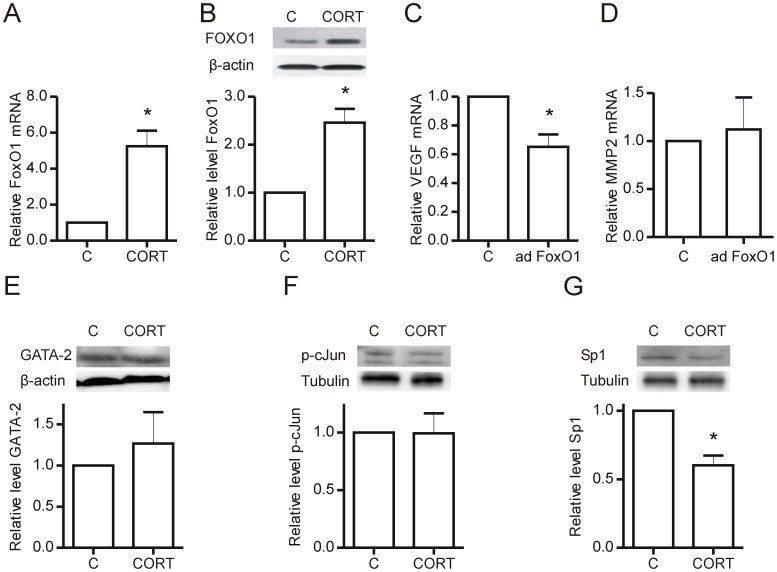
Corticosterone regulates FoxO1 and Sp1.Endothelial cells (1.0×106 cells) were plated in 35 mm2 dishes coated with type I collagen and treated with 600 nM corticosterone for 48 hours. Whole cell lysates were used for qRT-PCR or Western blotting. FoxO1 mRNA (A) and protein (B) increased significantly with corticosterone treatment (*p = 0.04 vs control; n = 3 and *p = 0.01 vs control, n = 4, respectively). Adenoviral overexpression of FoxO1 resulted in decreased VEGF mRNA (*p = 0.03 vs control, n = 4) (C), but did not change MMP-2 mRNA levels (n = 4) (D). GATA-2 (E), phosphorylated c-Jun (F) and Sp1 (G) levels were determined by Western blotting of corticosterone treated whole cell lysates, normalized either to tubulin or β-actin (*p = 0.03 vs control, n = 3 independent experiments). C – Control, CORT – Corticosterone, ad FoxO1– Adenovirally transduced constitutively active FoxO1.